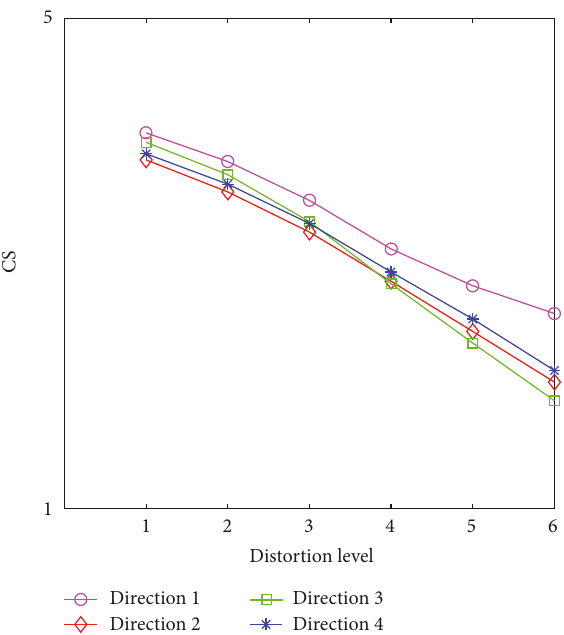
Figure 8: Scatter map of distortion level versus CS in different